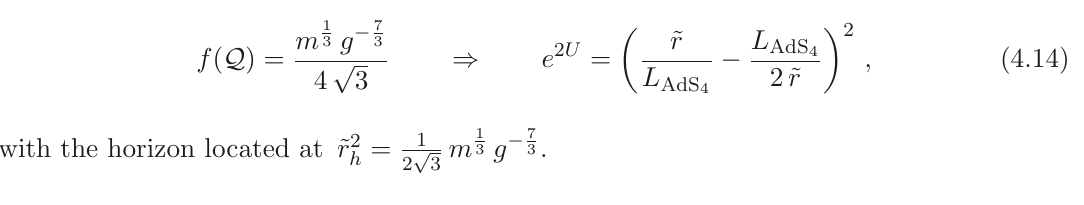
which connects with the attractor solution in (4.8). It corresponds to an extremal